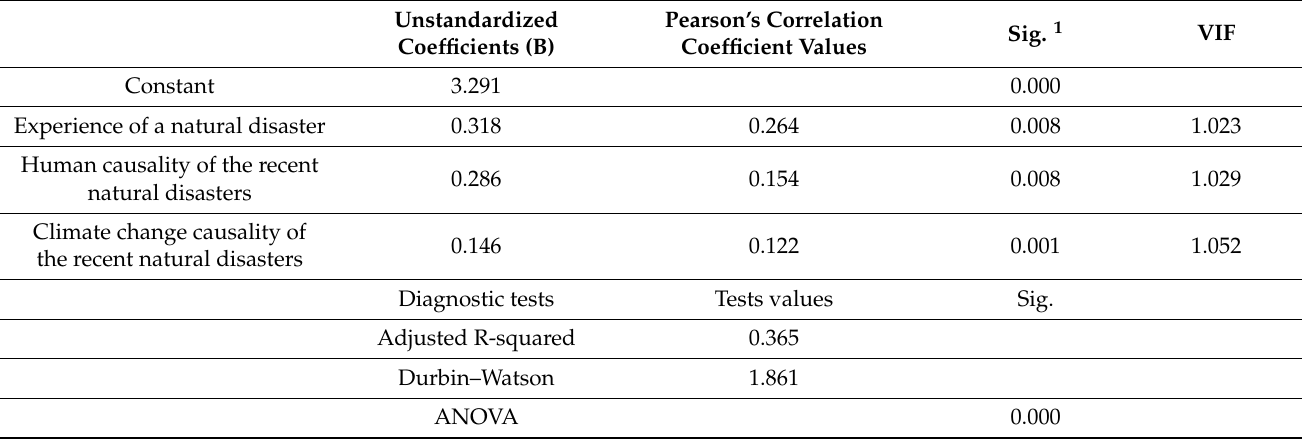
Table 8. Multiple linear regression model for environmental sensitivity analysis, coefficients and diagnostic